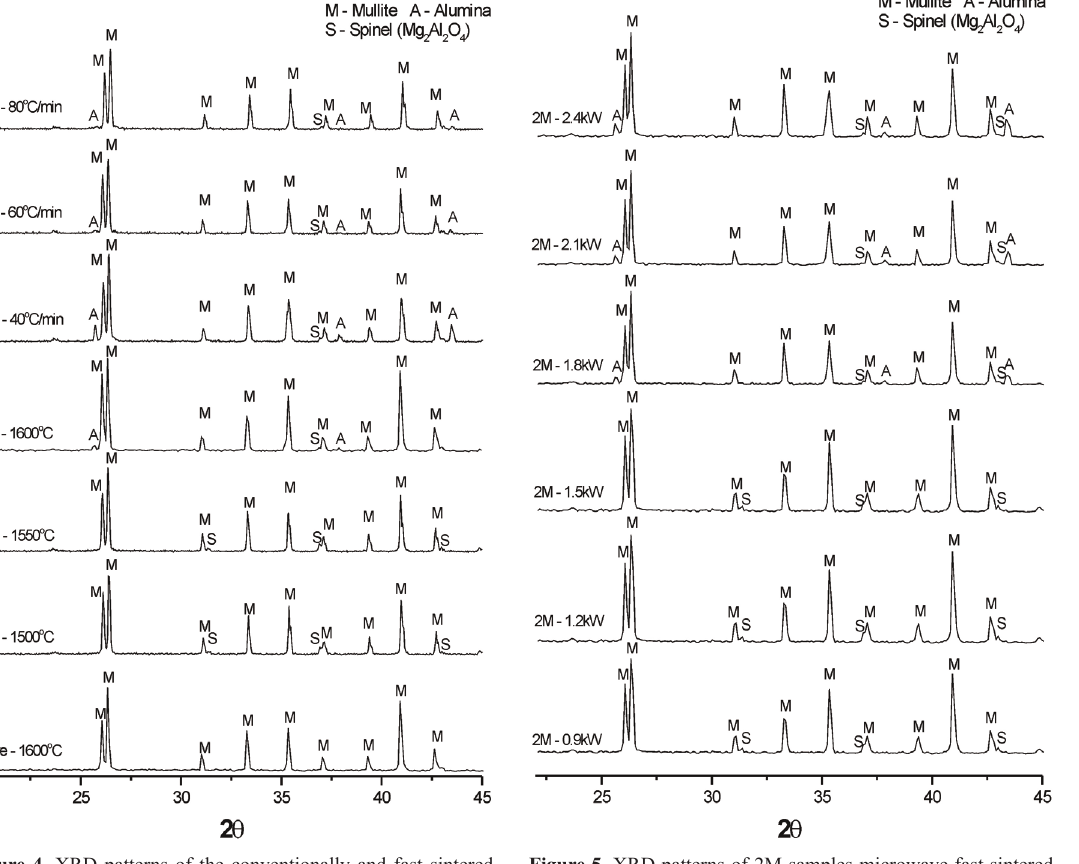
Figure 5. XRD patterns of 2M samples microwave fast sintered for